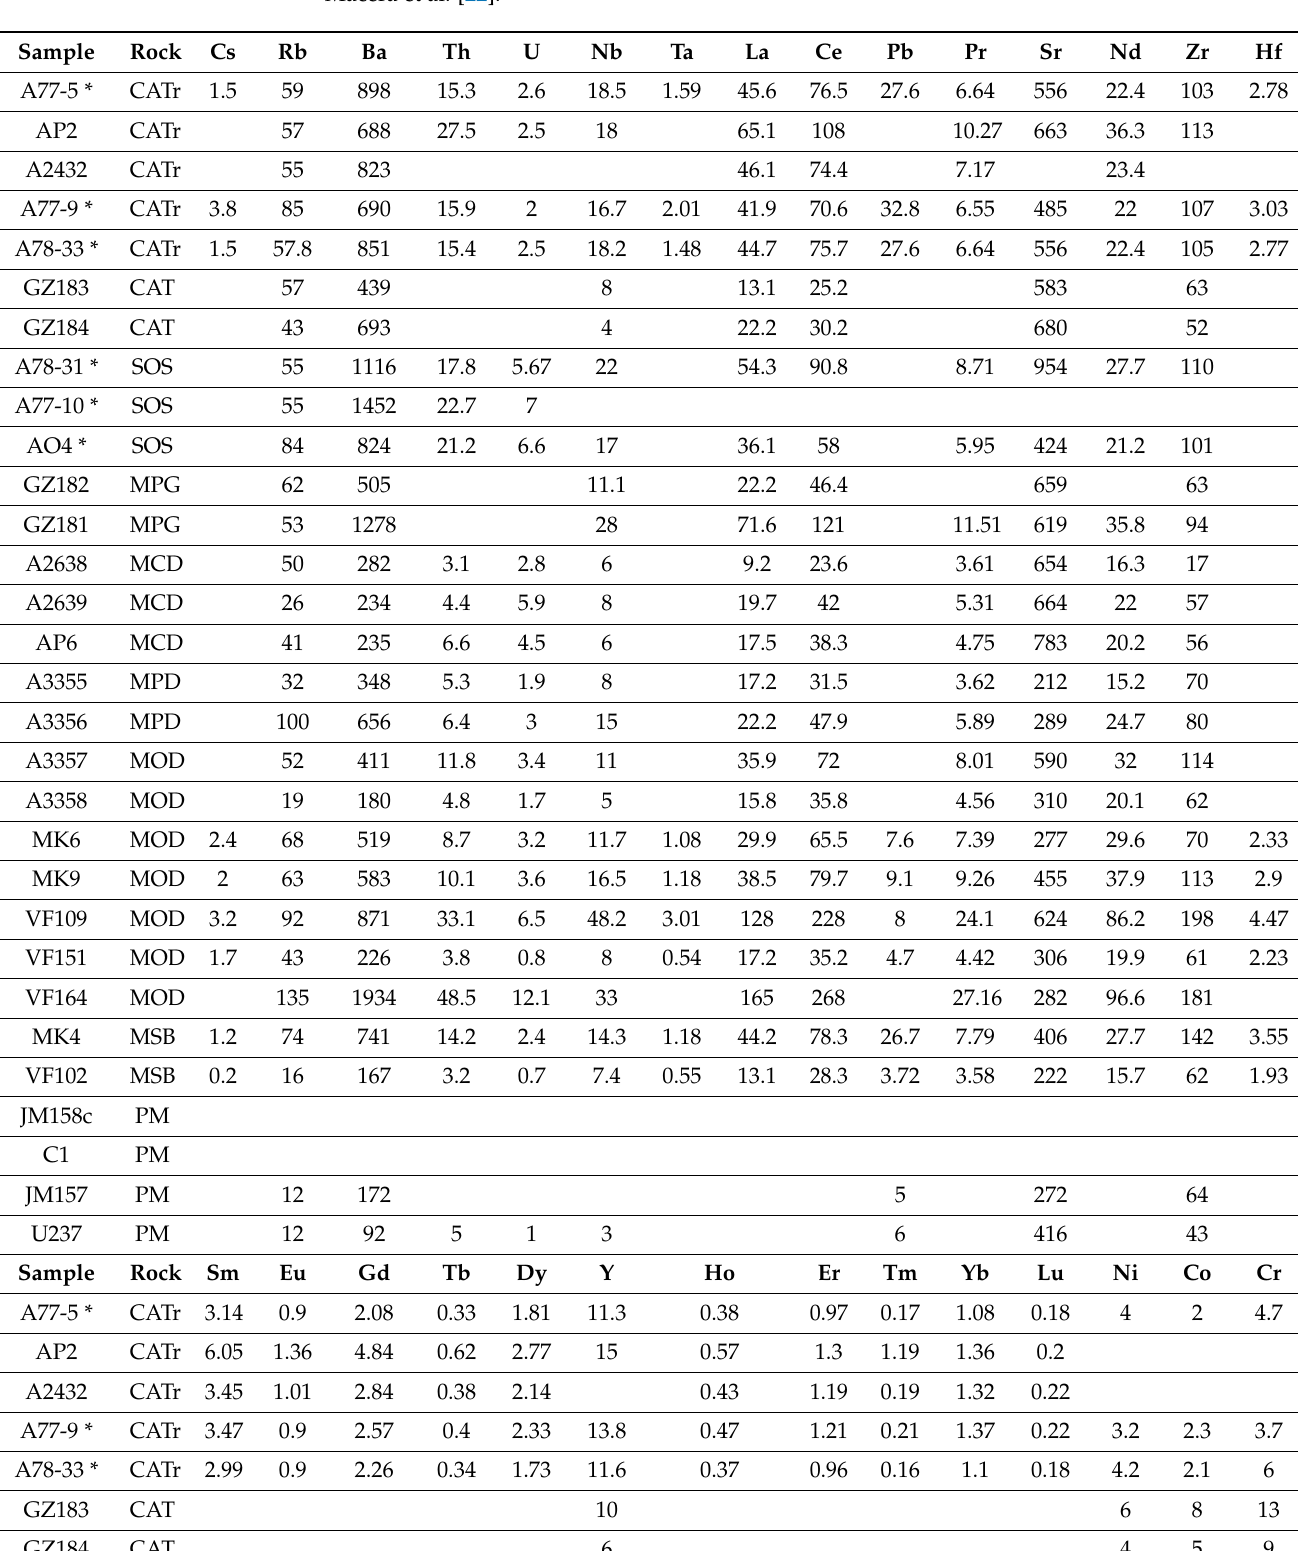
Table 3. Trace elements and rare earth element (REE) compositions of Corno Alto–M. Ospedale samplesand Re di Castello Parental Melts (PM) after [16,23,25,31]. Samples marked by * after Macera et al.